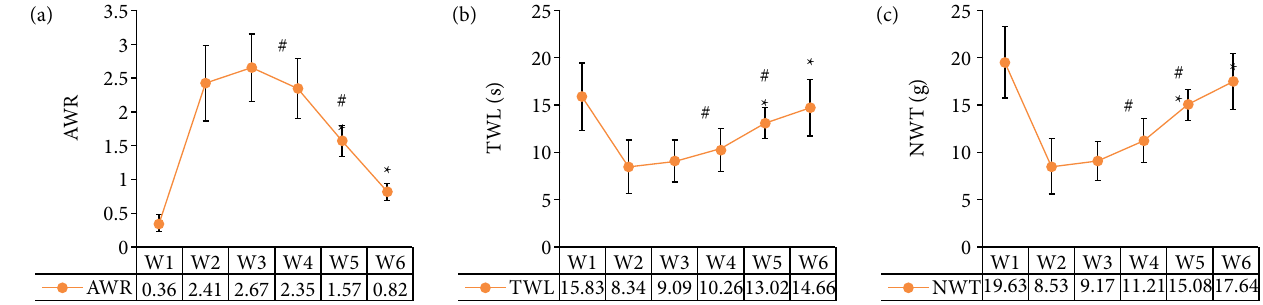
Figure 2 - Comparison of (a) AWR, (b) TWL and (c) MWT in rats. * indicates that the difference is statistically significant compared with group W3 (p < 0.05). # compared with W6 group, the difference is statistically significant (p < 0.05).